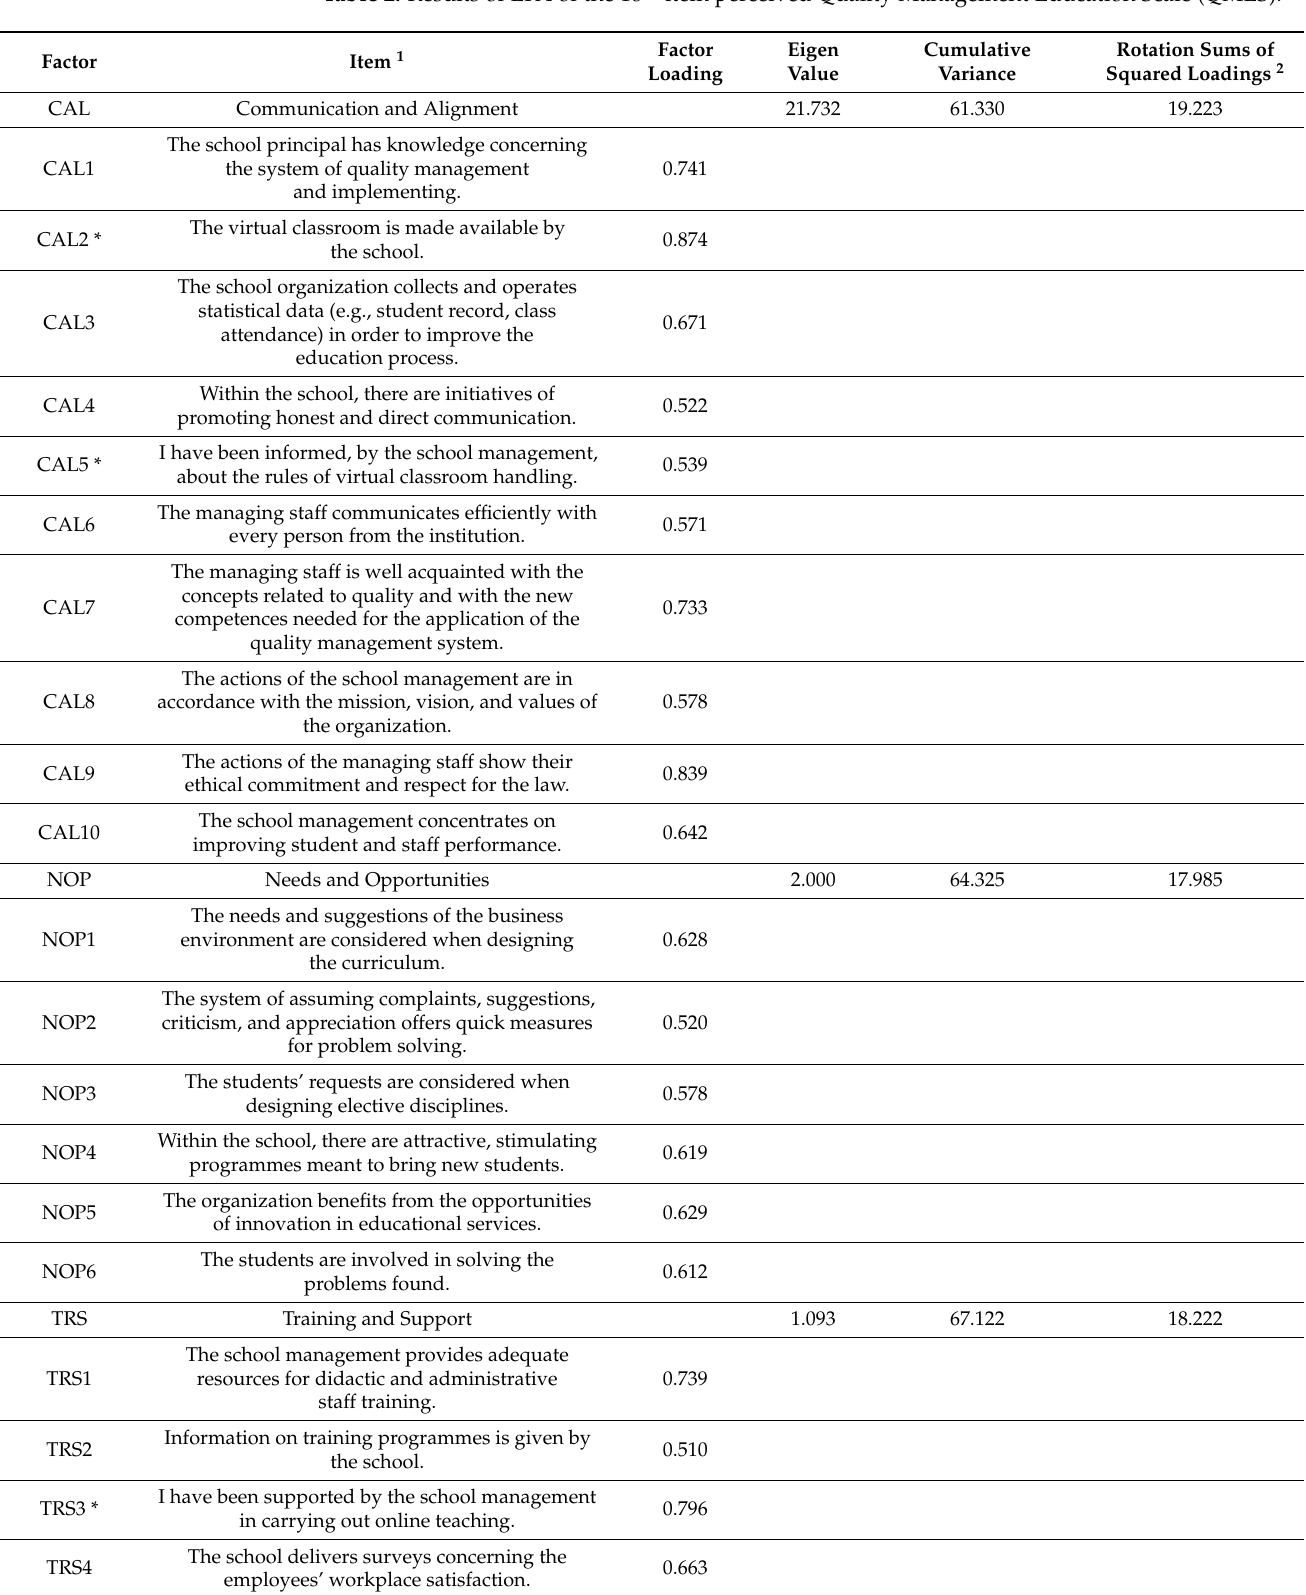
Table 2. Results of EFA of the 18—item perceived Quality Management Education Scale